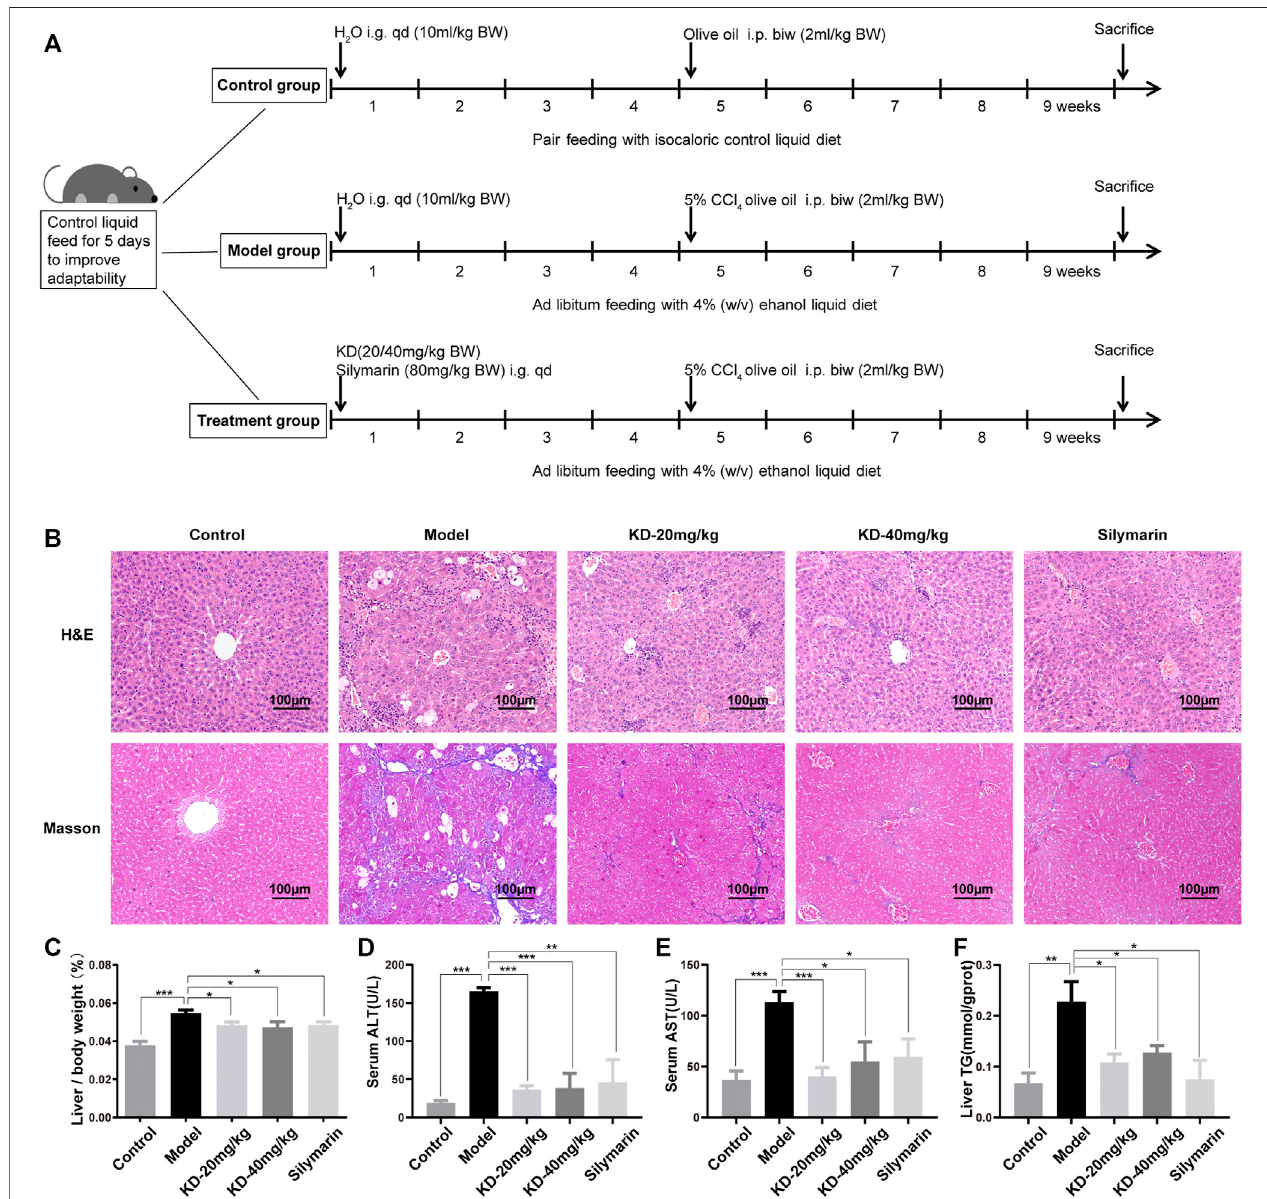
FIGURE 2 | Effects of KD on alcoholic liver injury in mice. (A) Schematic representation of the modeling of alcoholic liver injury in mice. (B) Images of H&E and Masson ’ s trichrome-stained sections of the mice liver. Scale bar: 100 µm. (C) Liver to body weight ratio. (D) ALT levels in the mice serum. (E) AST levels in the mice serum. (F) TG content of mice liver homogenate. ( n (cid:1) 5 – 7). Data represent the mean ± SEM. * p < 0.05, ** p < 0.01, *** p < 0.001 vs. the model group.